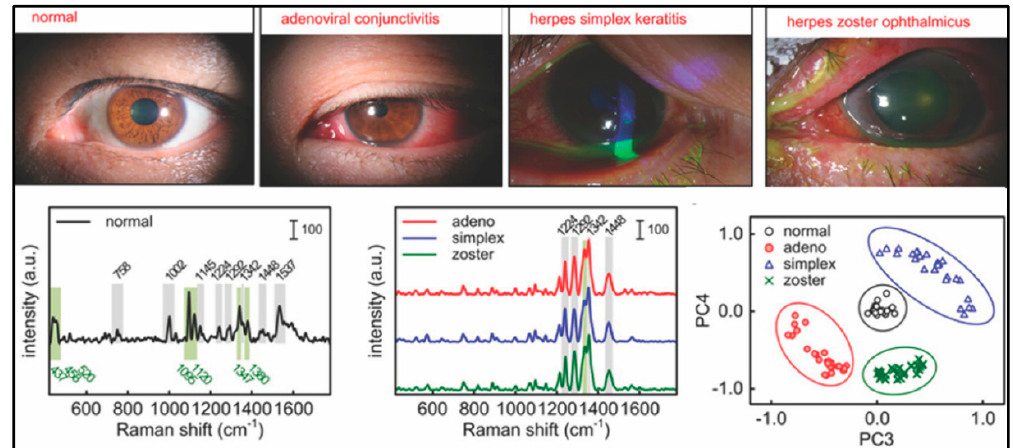
Figure 2. Direct, label-free cell membrane biomarker detection in bodily fluid using SERS. (Top) Photographs of a healthy and three types of keratoconjunctivitis, an infectious eye disease. Raman spectrum of (bottom left) a normal eye fluid and (bottom middle) fluid from the three types of eye infections. (Bottom right) PCA score plot classifying the normal and the three infected eyes based on the SERS spectra. Reproduced with permission from Reference [91] American Chemical Society